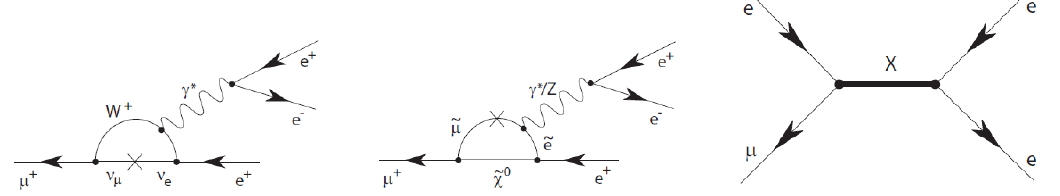
Figure 1: (left to right) Standard Model Feynman diagram for the neutrinoless µ + → e + e + e − process via neutrino mixing, diagram for cLFV involving supersym- metric particles (dipole type interaction), diagram for cLFV at tree level involving new particles (contact type interaction).